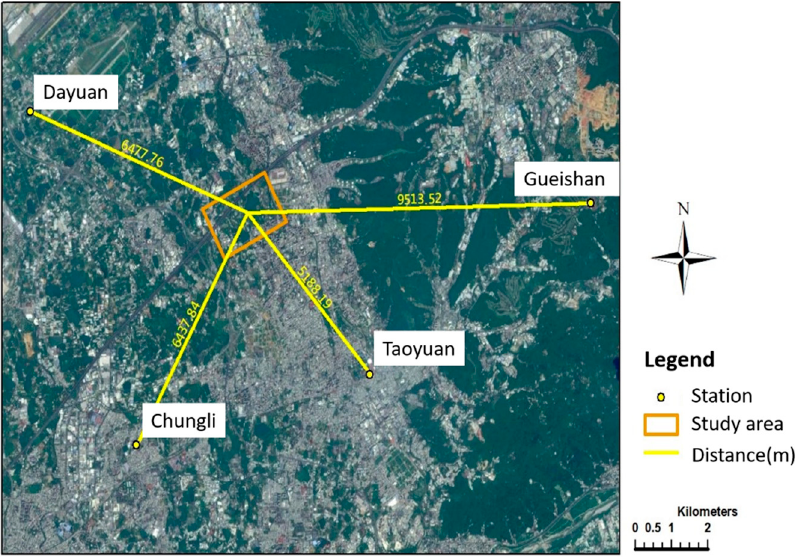
Figure 4. Locations of the monitoring stations.